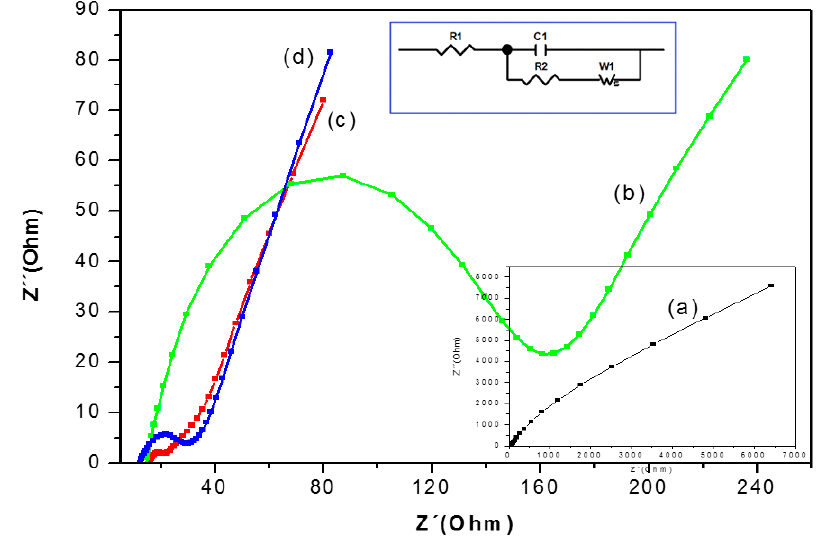
Figure 2. The Nyquist plots for ( a ) bare graphite (GE); ( b ) electrode NAF/LAC; ( c ) electrode TiO 2 /LAC; and ( d ) TiO 2 /NAF/LAC in the presence of 0.1 M KCl solution containing 1 mM K 3 Fe(CN) 6 /K 4 Fe(CN) 6 (1:1) by applying an AC voltage with 50 mV amplitude at a frequency range of 100 mHz to 100 KHz.